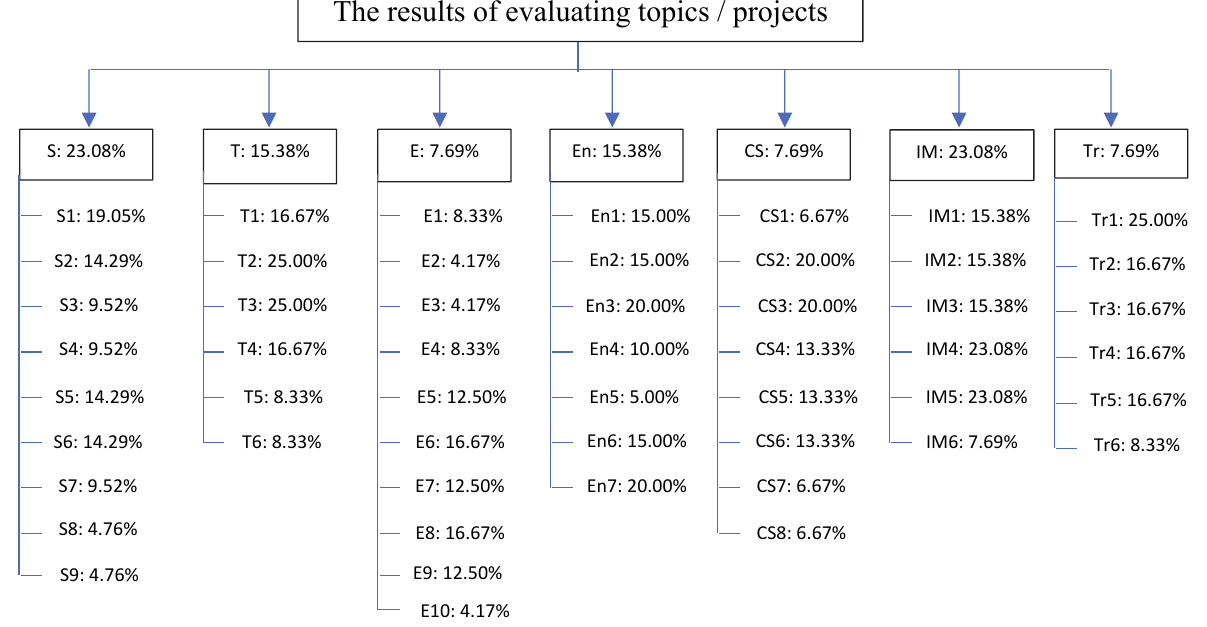
Fig. 4. Weight of each criterion for evaluating socio-economic efficiency of natural science topics /projects